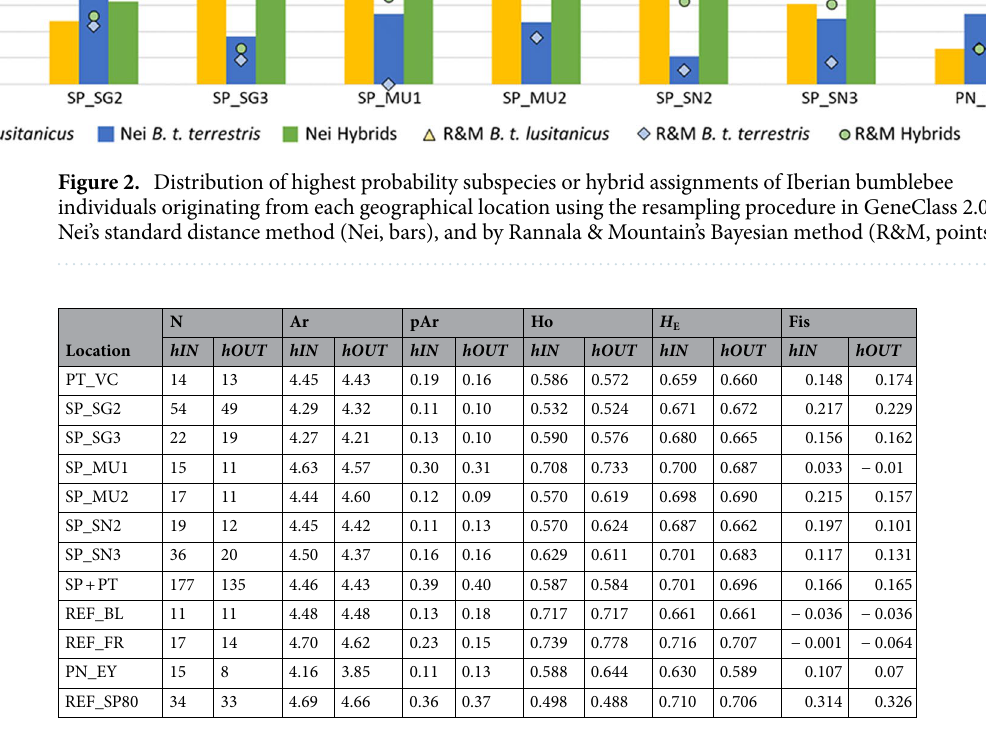
Table 2. Allelic richness (Ar), private allelic richness (pAr), observed heterozygosity (Ho), expected heterozygosity ( H E ) and inbreeding index (Fis) were calculated independently for each population based on the genotypes of female individuals. N = population size. hIN includes all individuals while hOUT excludes hybrid individuals (morphological and